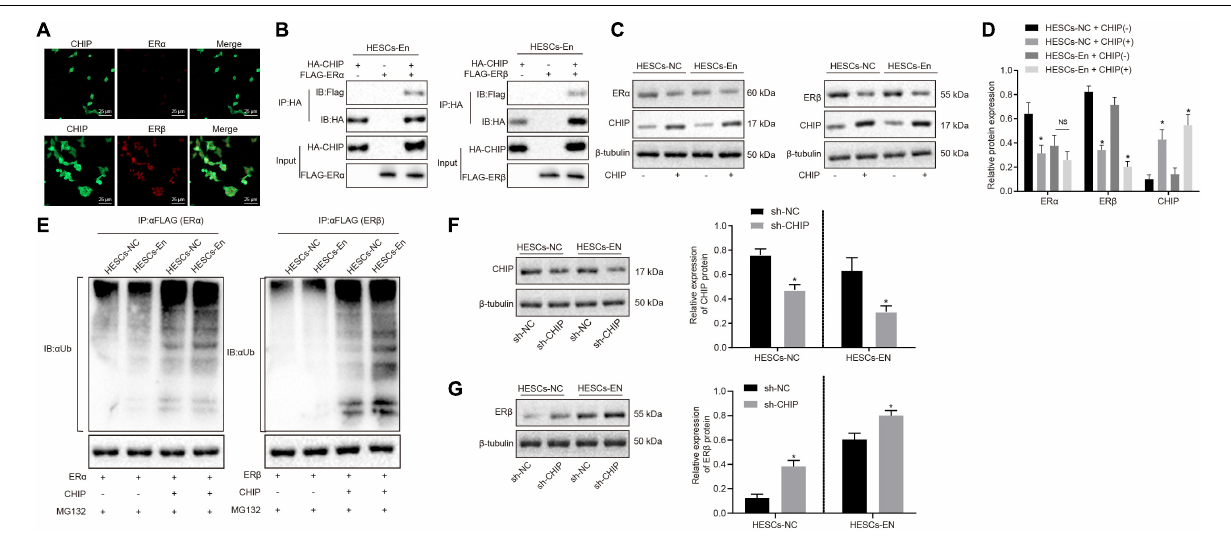
FIGURE 3 | CHIP degraded ER β by ubiquitin-proteasome pathways in HESCs in vitro . (A) The distribution of CHIP, ER α and ER β in the cells. (B) The interaction of CHIP, ER α and ER β in HESCs-En cells by Co-IP. (C) The protein expression of ER α and ER β in HESCs-NC and HESCs-En cells measured by Western blot analysis. (D) The statistical analysis of panel C. (E) Ubiquitin of ER α and ER β proteins in HESCs-NC and HESCs-En cells by ubiquitin assay. (F) | The protein expression of CHIP following sh-NC and sh-CHIP treatment measured by Western blot analysis. (G) The protein expression of ER β following sh-NC and sh-CHIP treatment measured by Western blot analysis. Comparisons between two groups were analyzed using independent sample t -test. * p < 0.05 vs. the sh-NC or HESCs-NC + CHIP − ; # p < 0.05 vs. HESCs-En + CHIP − . Cell experiments were conducted in